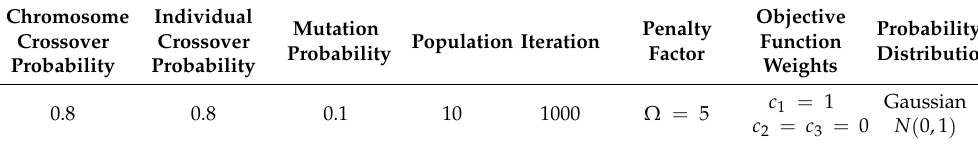
Table 2. Parameter settings for the station scenario.